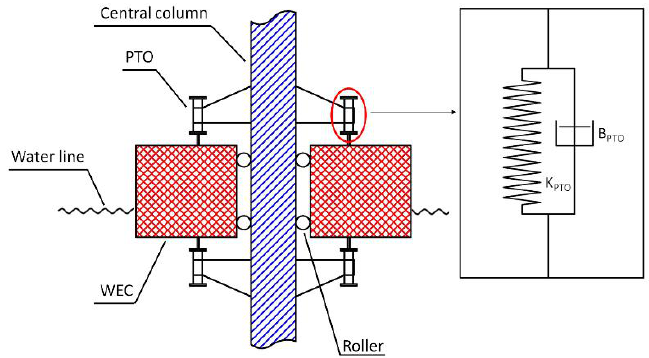
Figure 2. Connection detail between the column of semisubmersible and the wave energy converter (WEC).